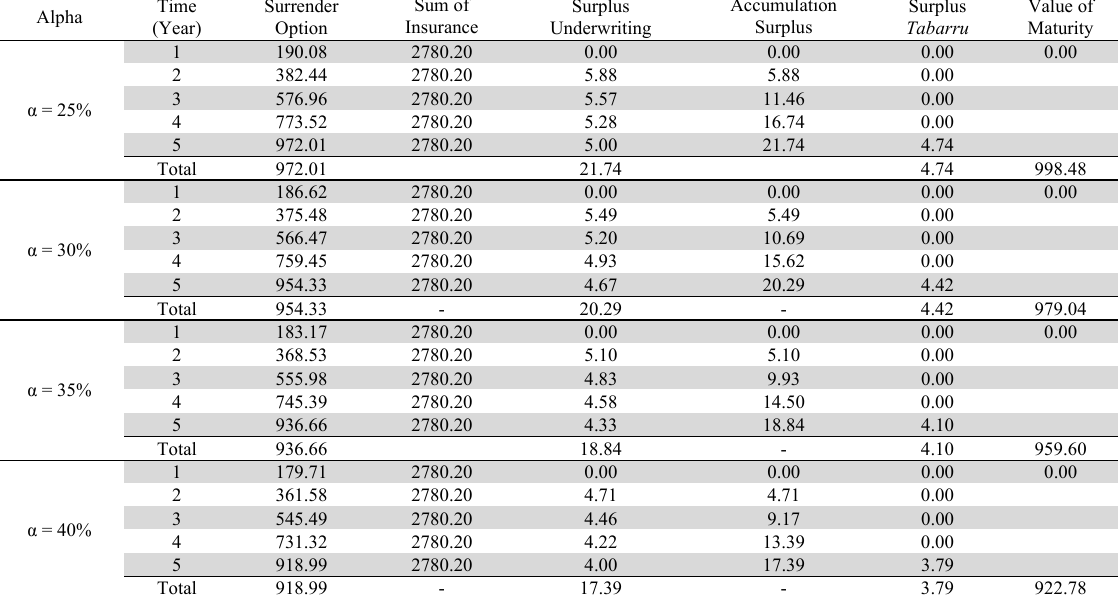
The value of surrender option, sum of insurance coverage and underwriting at the inception of insurance under